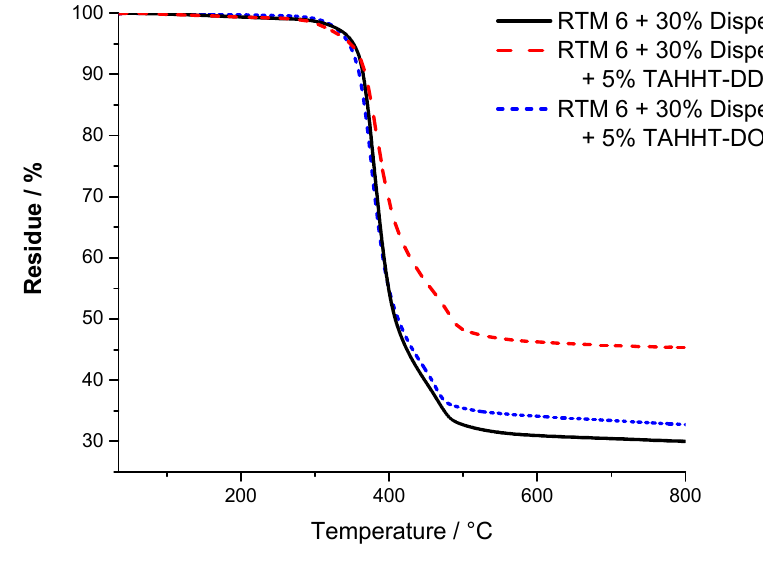
Figure 13. TG curves of Disperal-containing samples measured under N 2 -atmosphere.